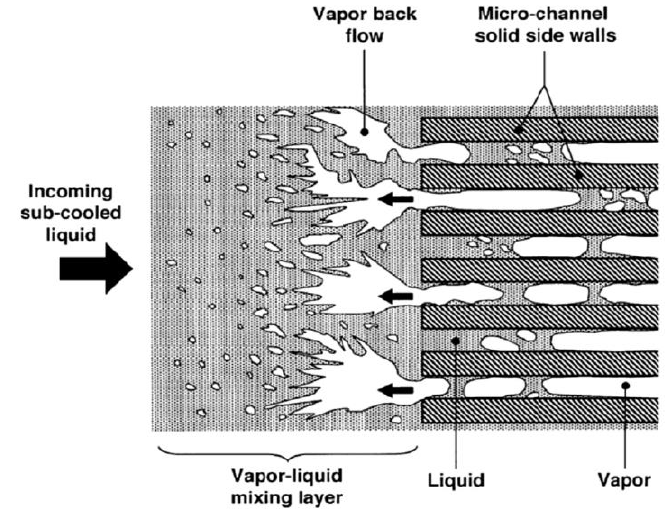
Figure 9. Schematic sketch of backflow [32].